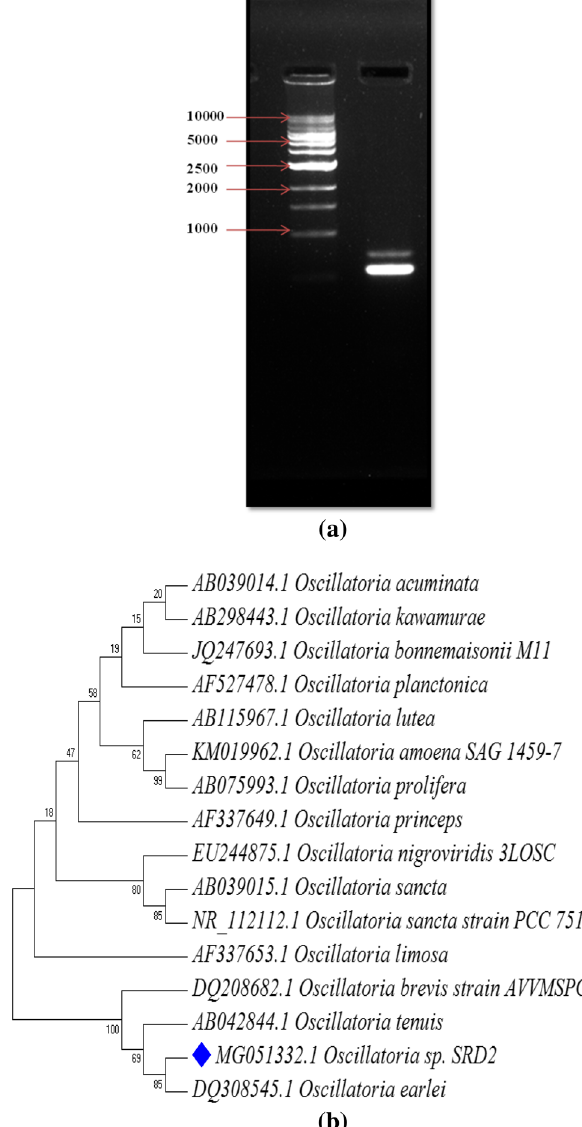
Fig. 3 Cultivation of algae